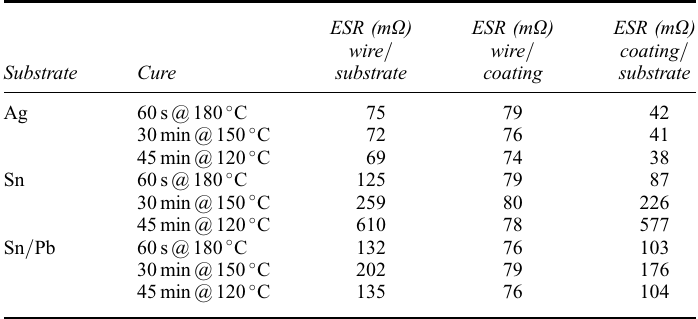
TABLE IV ESR Numbers from (1) Wire to Substrate, (2) Wire to Coating and (3) Coating to Substrate Measured with Adhesive A1 on Different Substrates.